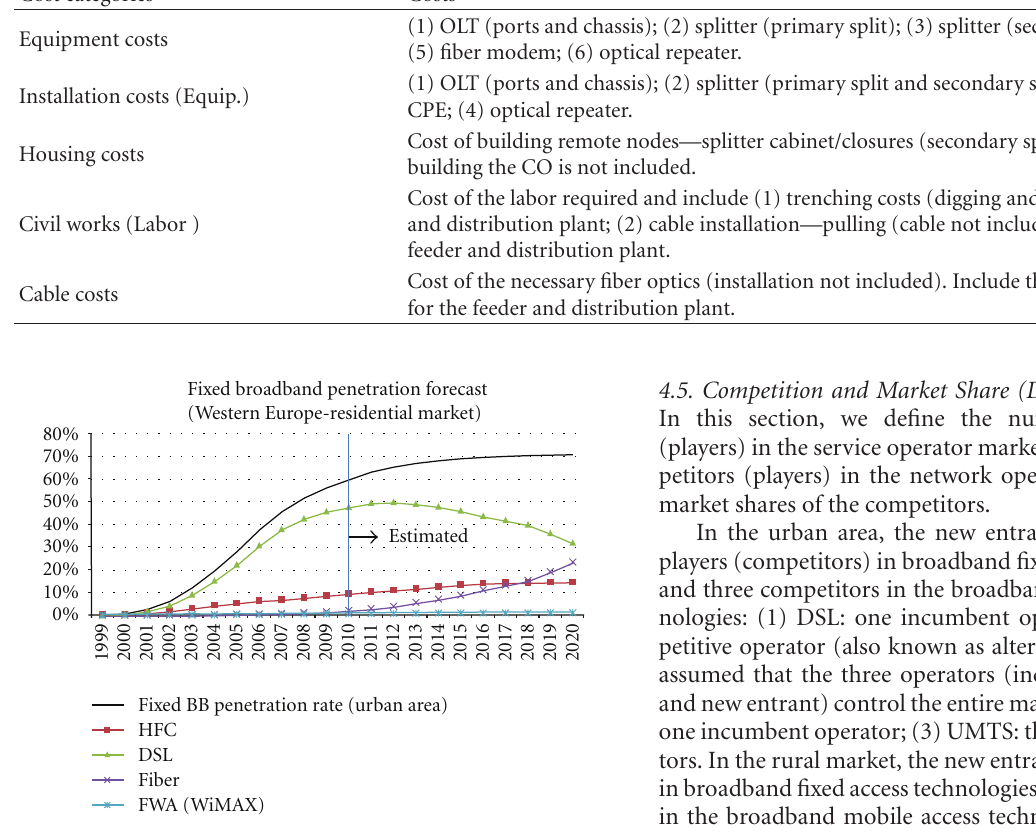
Figure 2: Fixed BB penetration forecasts (residential market).